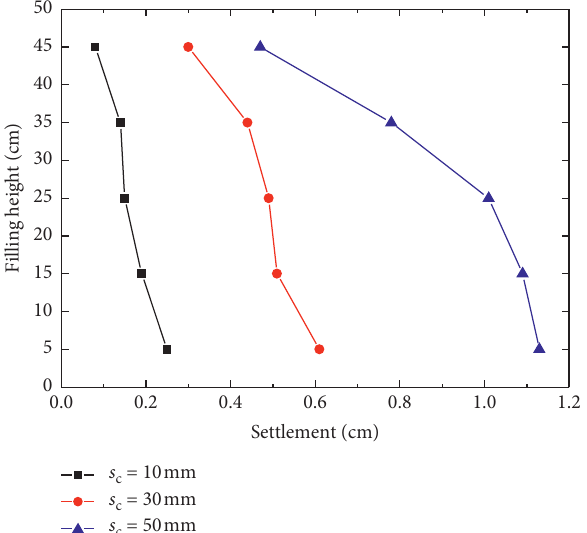
Figure 7: Variation of the settlement with filling height under different reinforced conditions.